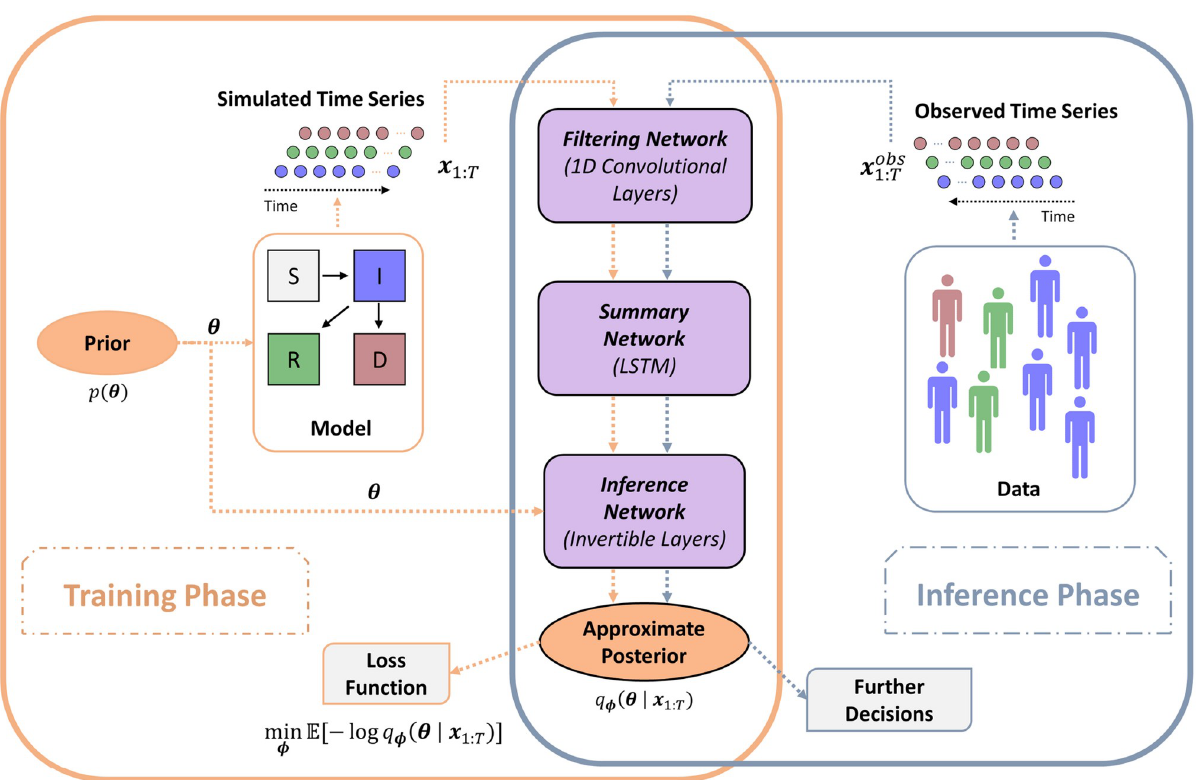
Fig 1. Structure and workflow of OutbreakFlow. During the training phase (orange frame on the left), the assumed epidemiological model is used to simulate time series resembling the observed epidemiological data, based on prior distributions of the unknown parameters. The synthetic time series are used to train the composite neural network consisting of (i) a convolutional filtering network, which extracts relevant features while preserving the temporal structure of the data, (ii) a summary network, which reduces the transformed time series to a fixed-sized vector of maximally informative representations, and (iii) an inference network, which estimates the joint parameter posterior from these data representations. During the inference phase (blue frame on the right), the real epidemiological data x obs are passed to the trained network to infer the posterior distribution of the unknown 1: T disease parameters. A full description of the architecture and the methodology is provided within Materials and